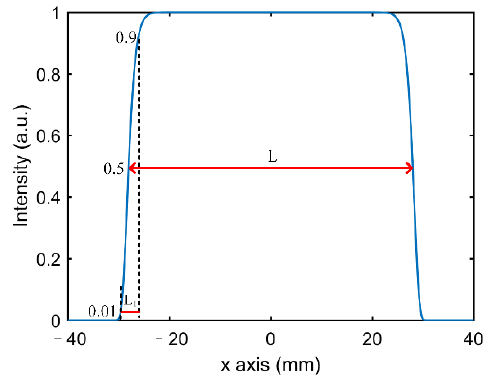
Figure 9. One-dimensional (1D) pump distribution of the gain slab.